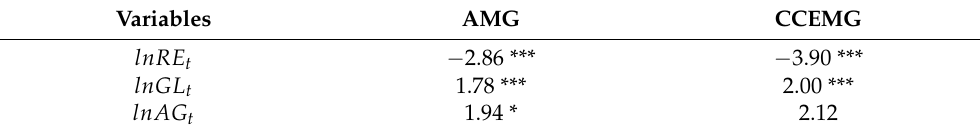
Table 10. Robustness check test